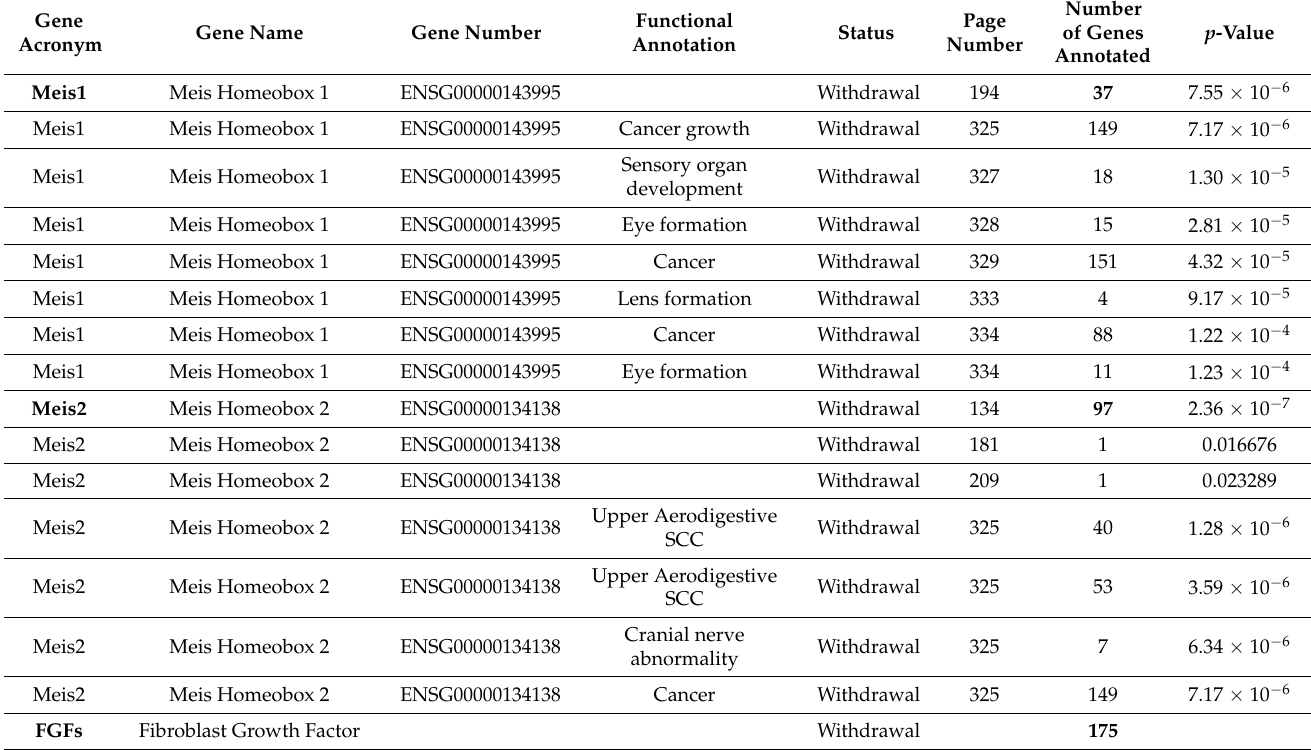
Table 7. Epigenomic Hits for Limb Congenital Anomalies Extended Exploration, Schrott EWAS